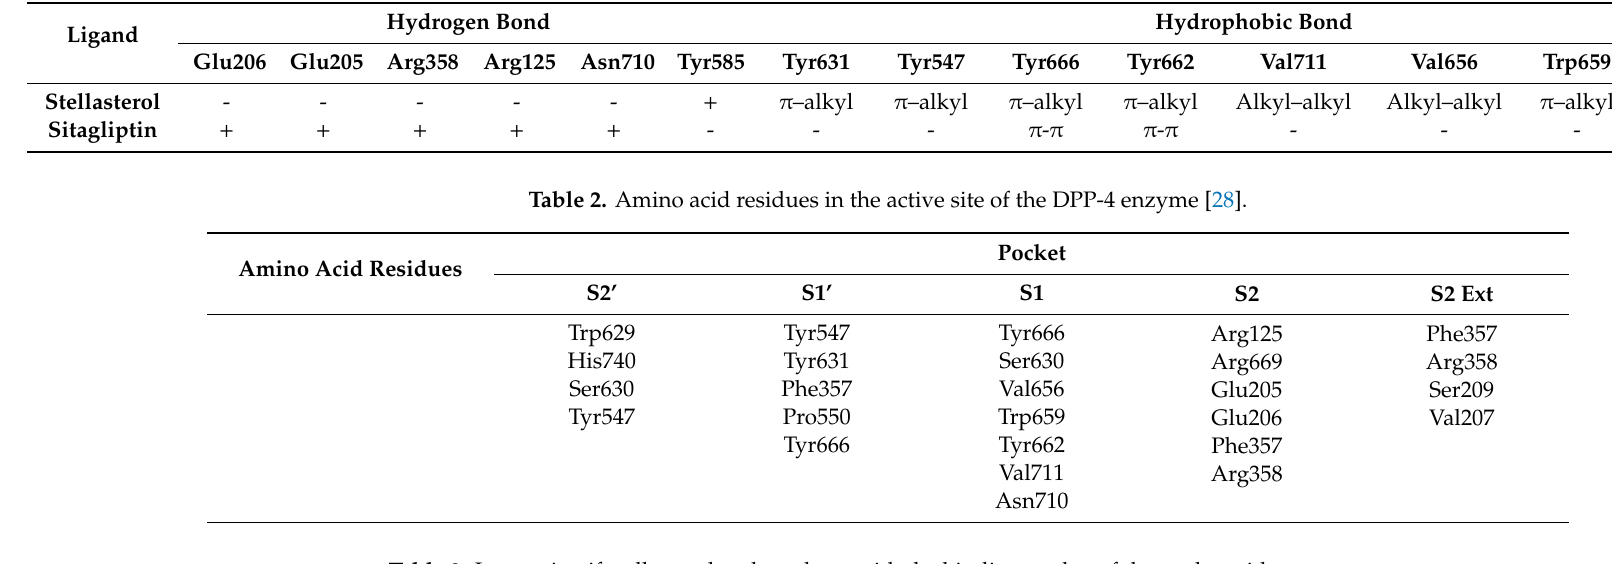
Table 3. Interaction if stellasterol and acarbose with the binding pocket of the α -glucosidase